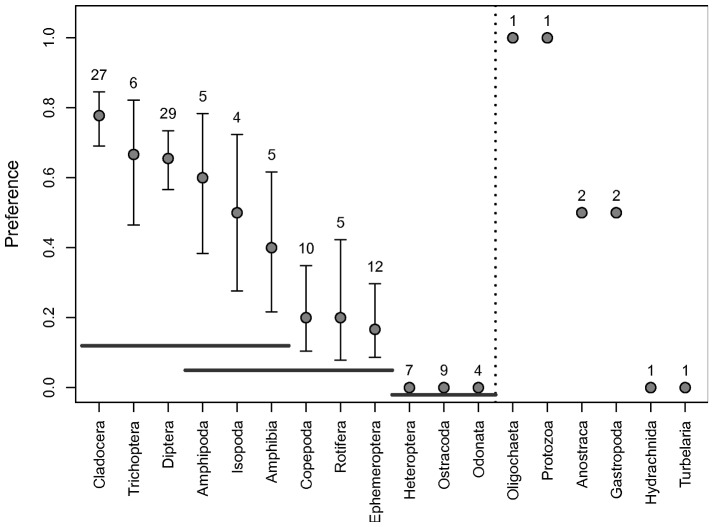
Relative vulnerability of prey taxa most often used in previous experiments.Based on data in Supporting Information Table S1. Preference = proportion of experiments in which the prey taxon was most preferred (mean ± SE). Number of experiments that included a given prey taxon is stated above each error bar. Dotted line separates prey types used in >3 experiments (to the left) and <3 experiments (to the right). Horizontal grey lines denote prey groups that do not differ significantly according to multiple comparisons of means (P>0.05).